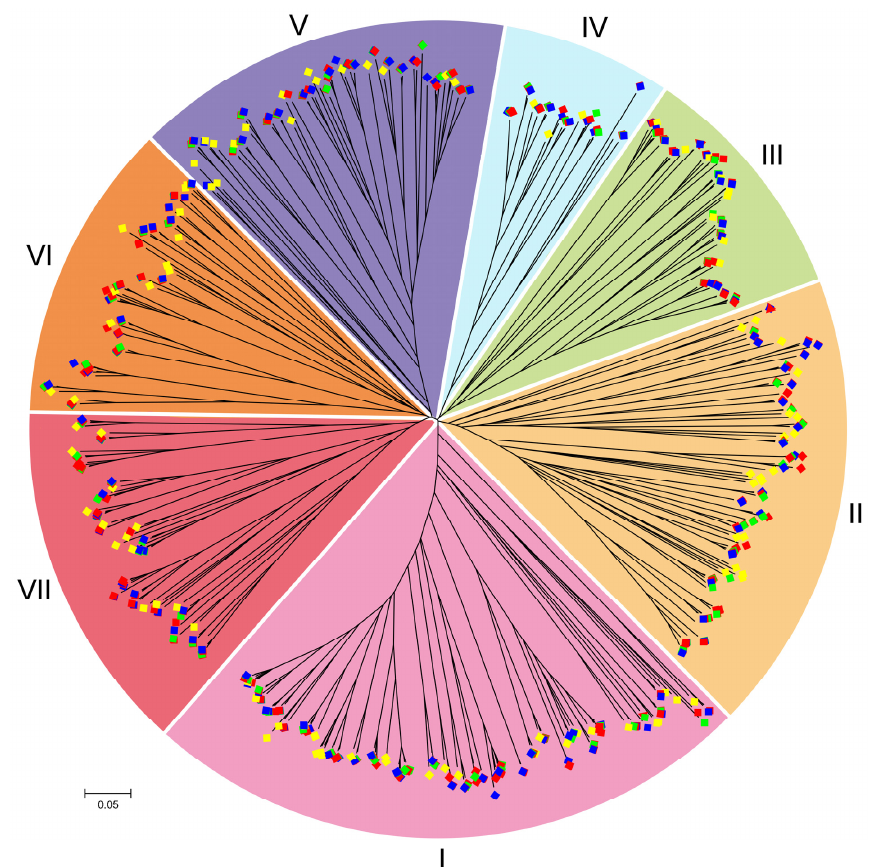
Figure 2. Phylogenetic relationships of nsLTP proteins among B. napus , B. rapa , B. oleracea and A. thaliana . This tree was generated using the protein sequences of their 8CM domains. BnLTP, BrLTP, BoLTP and AtLTP are shown with the red (Bn), green (Br), blue (Bo) and yellow (At) squares, respectively.